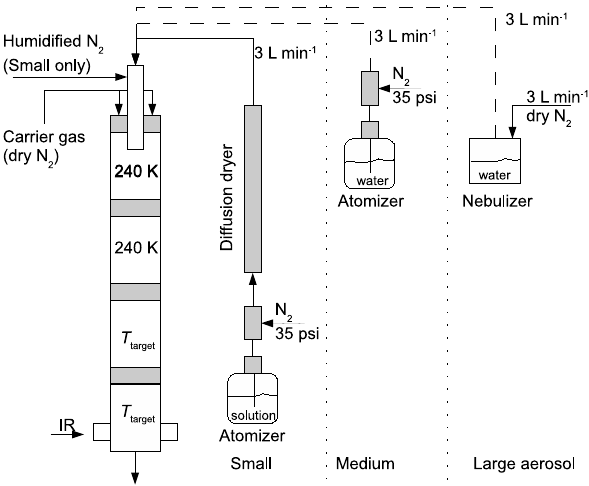
Fig. 1. Setup of cryogenic aerosol flow tube apparatus showing the three alternative configurations for aerosol